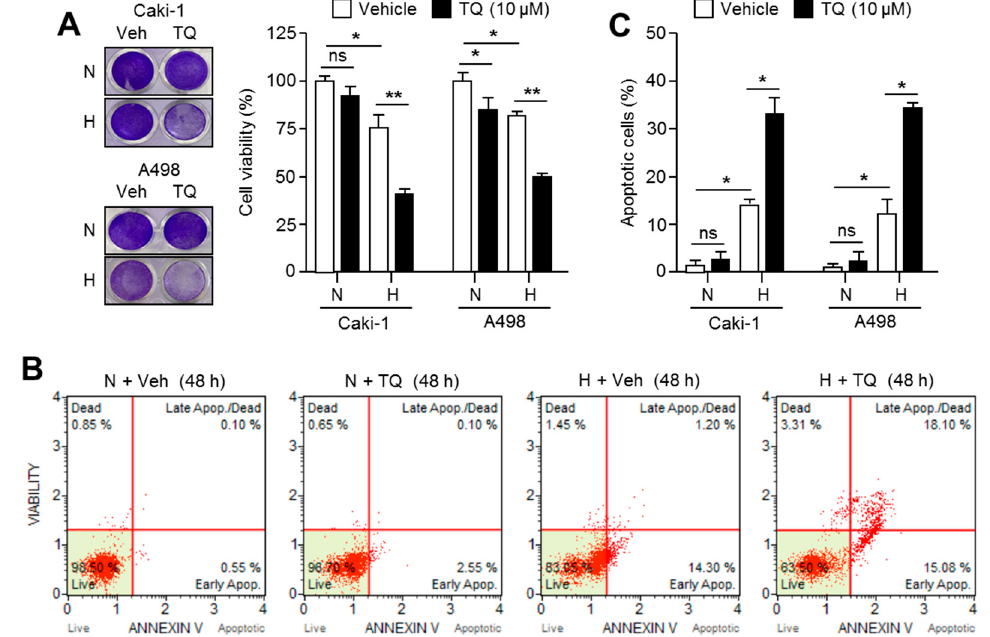
Figure 7. Hypoxic renal cancer cells are more sensitive to TQ-induced apoptosis. ( A ) TQ decreases cell viability in hypoxic renal cancer cells. Caki-1 and A498 cells were incubated with 10 μ M of TQ for 48 h under normoxia or hypoxia. Crystal violet staining images are shown (left panel). Quantitative cell viability is also shown (right panel). The values represent the mean ± SD of three independent experiments performed in duplicate; * p < 0.05 and ** p < 0.01. ( B , C ) TQ enhances hypoxia-induced apoptosis in renal cancer cells. Caki-1 and A498 cells were incubated in the absence or presence of 10 μ M of TQ for 48 h under normoxia or hypoxia. The values represent the mean ± SD of three independent experiments performed in duplicate; * p < 0.05.